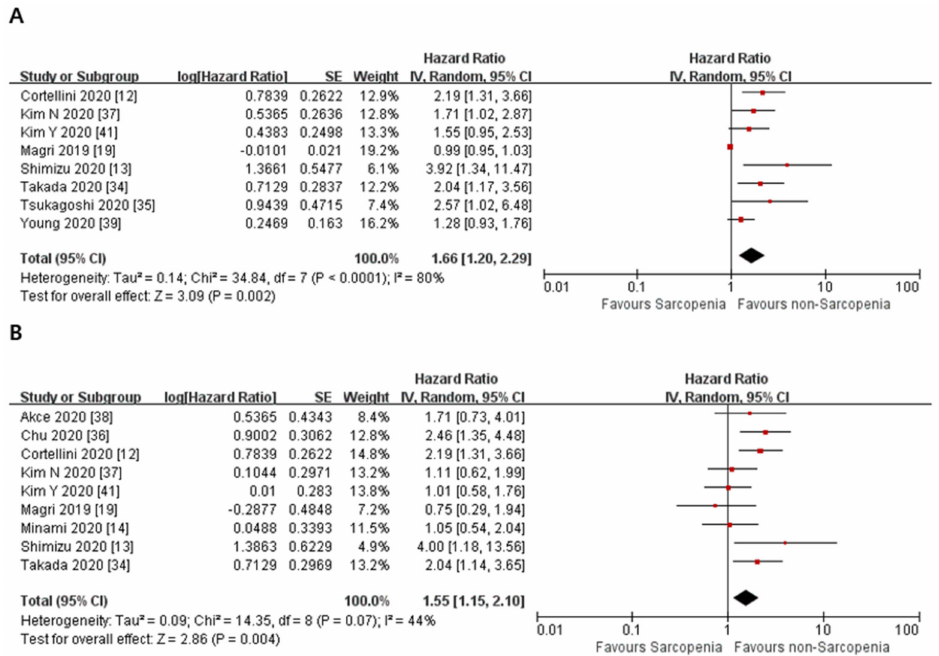
Figure 2. Forest plots of hazard ratios of sarcopenia on overall survival in cancer patients treated with immune checkpoint inhibitors. ( A ) Overall survival in the univariate analysis. ( B ) Overall survival with adjusted